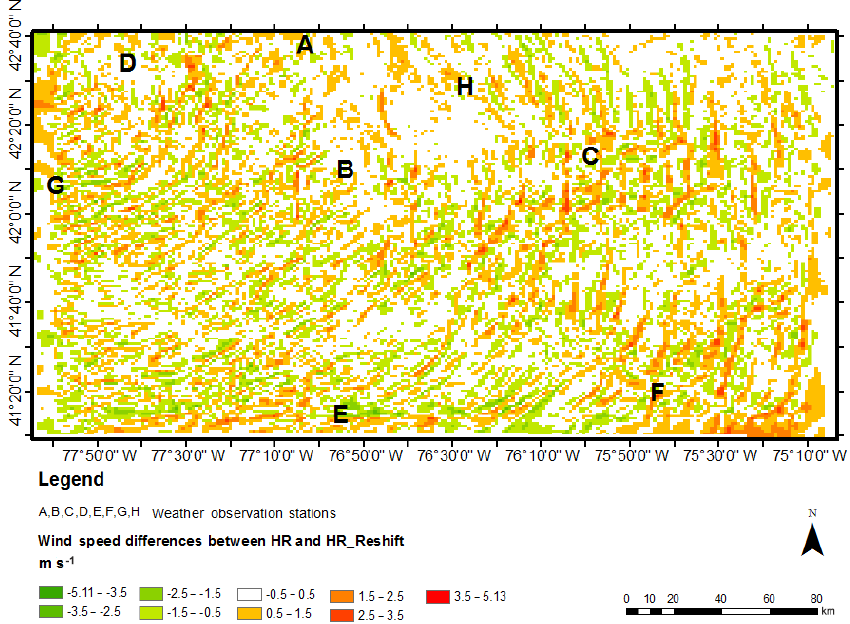
Figure 13. Wind speed difference between HR and HR_RESHIFT on 14 May 15:00EST, 2015, showed a wave pattern.